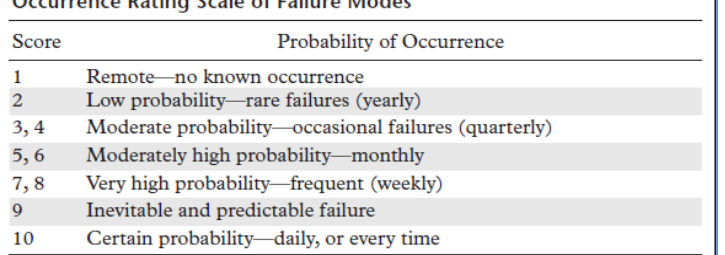
Figure 3 . Occurrence ra�ng scale of failure modes